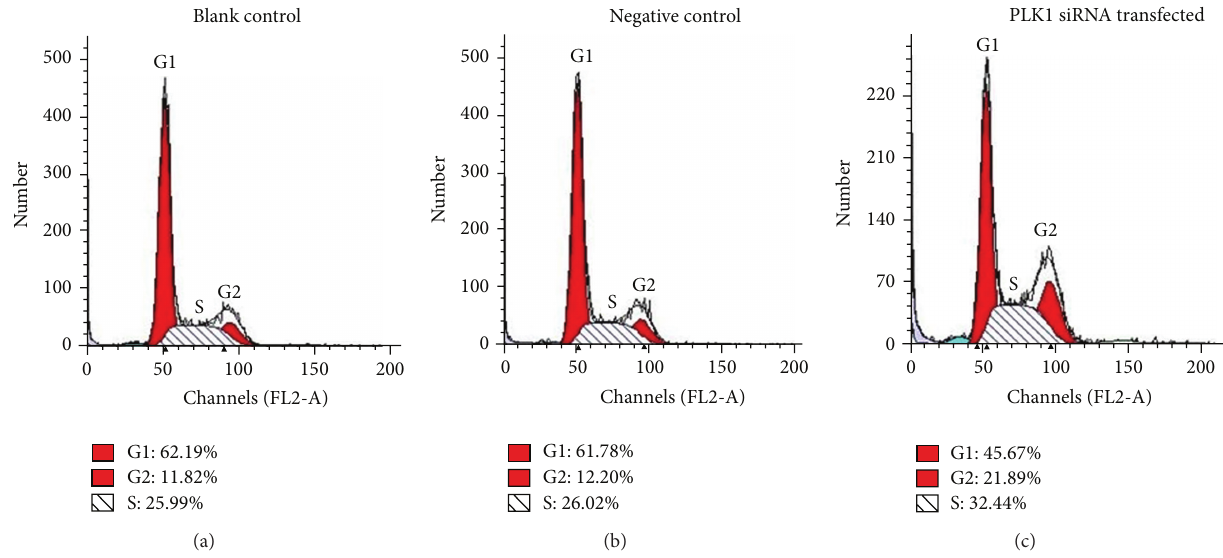
Figure 3: Knockdown of PLK1 in HCC promotes cell cycle arrest. BCL-7402 cells were transfected with PLK1 siRNA. 48h later, cells were harvested and subjected to flow cytometry analysis for cell cycle progression. Data are representative of at least 3 independent experiments.